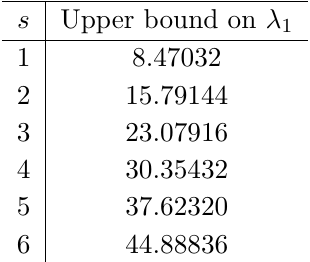
≈ 23 . 07856 [4], 7 which 24